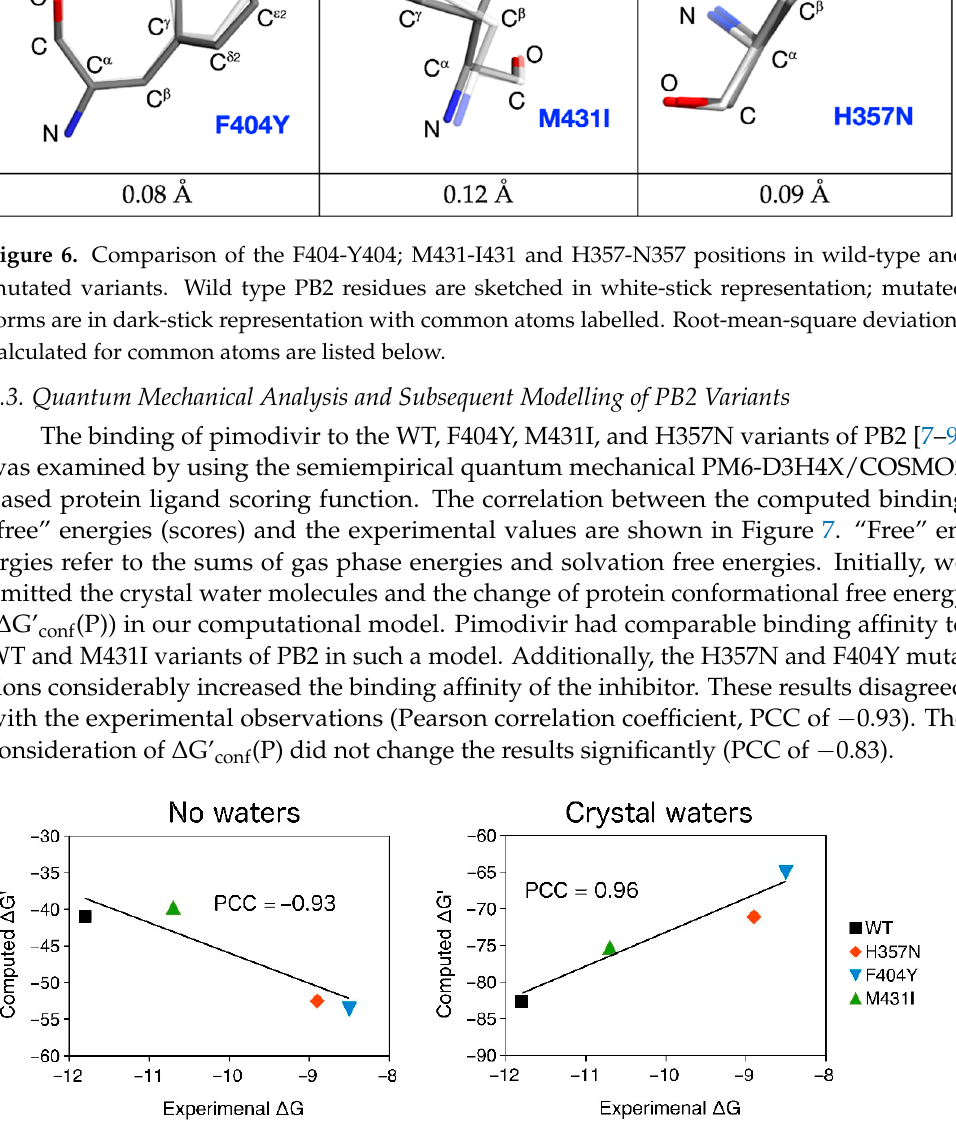
Figure 7. The PM6-D3H4X/COSMO2 binding “free” energies of pimodivir to WT, H357N, M431I, and F404Y variants of PB2 plotted against the experimental binding free energies. The change con- formational “free” energy of the protein was not considered. All in kcal.mol − 1 .